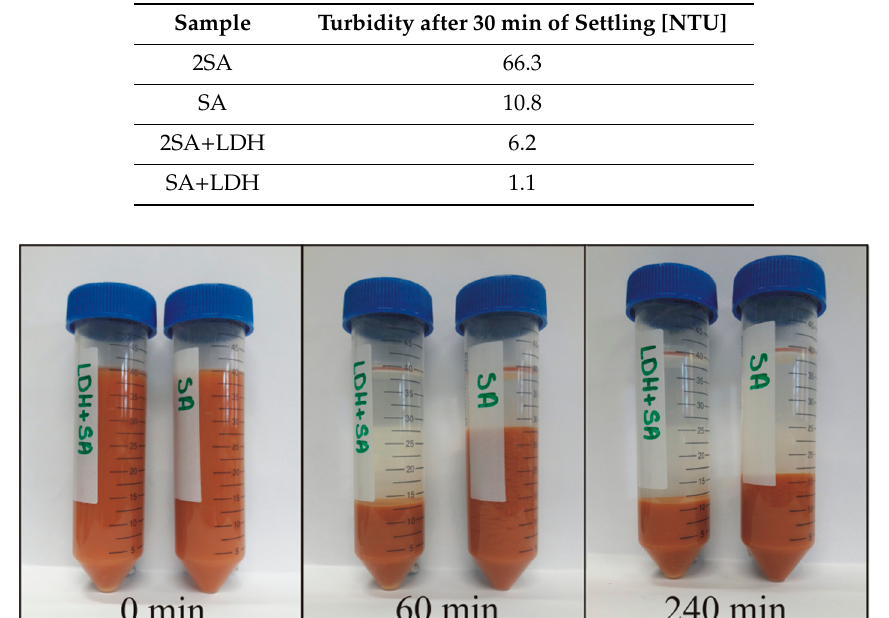
Figure 12. The sedimentation behavior of solid residues versus time for SA + LDH (left tube) and SA (right tube).